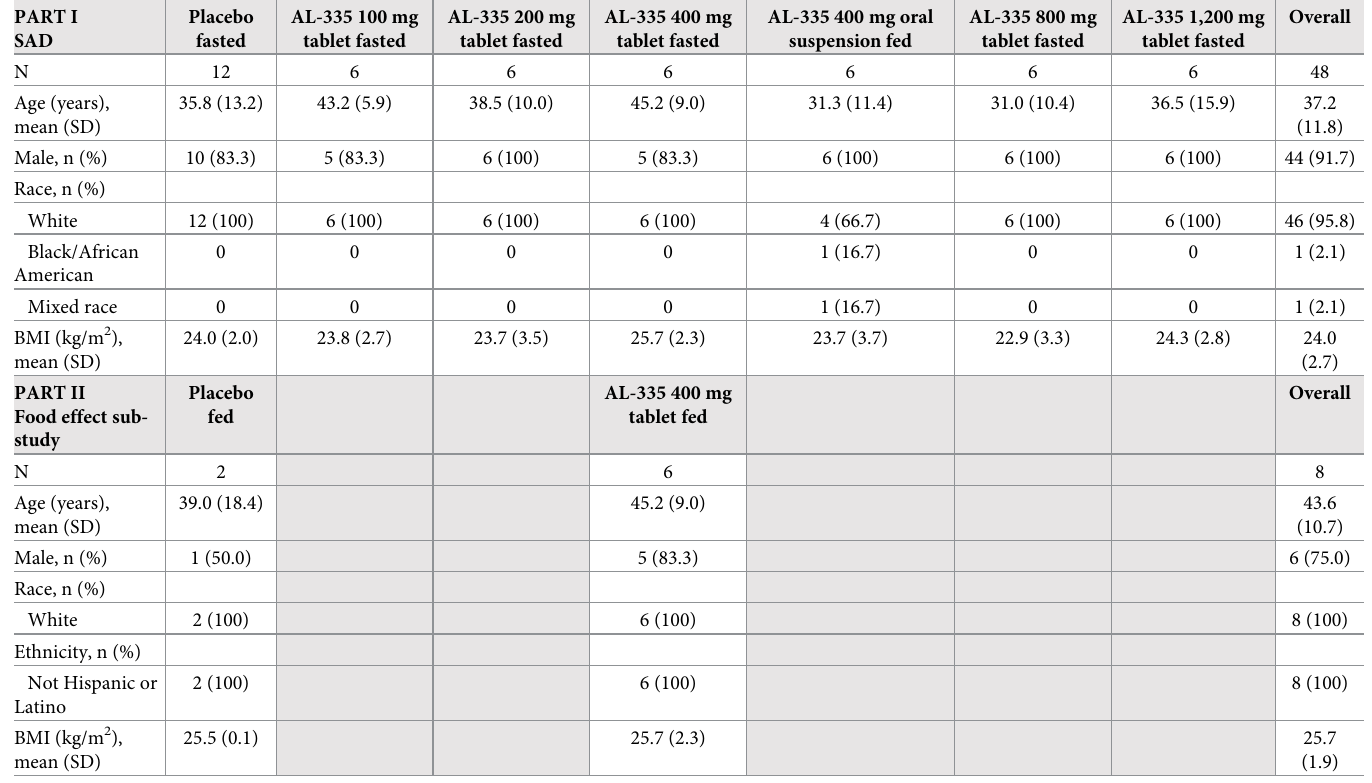
Table 1. Subject baseline demographics and disease characteristics in Parts I and II; SAD and food effect sub-study.